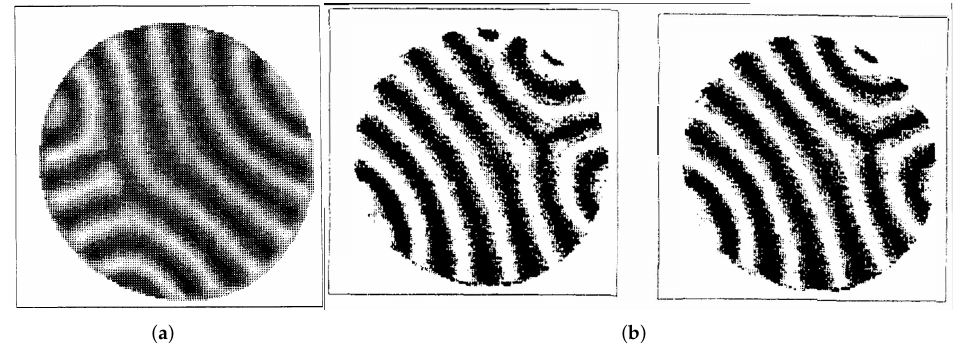
Figure 1. ( a ) An experimentally observed pattern of rolls in the Rayleigh–Bénard convection, which demonstrates a junction of domain walls (grain boundaries). The pattern corresponds to overcritical- ity ε = 1; see Equation (23). ( b ) Similar patterns observed at ε = 1.8 ( left ) and 2 ( right ). Reprinted with permissions from Ref.